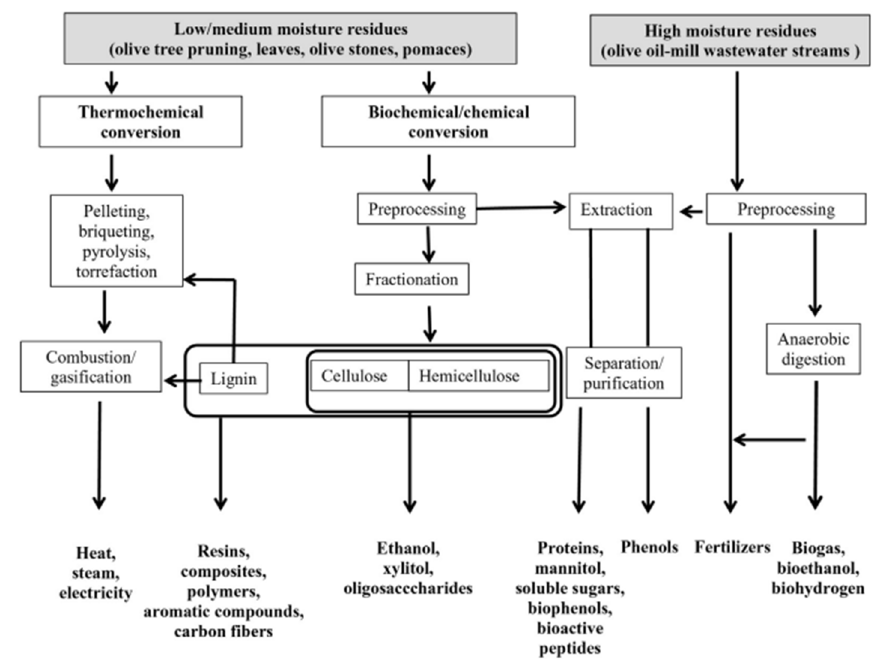
Figure 17. Valorization Scheme for the Different Residues Generated in the Olive Oil Industry. Reprinted with permission from Reference [234]. Copyright 2015. Elsevier. Table 12. Different identified circular pathways and the related literature